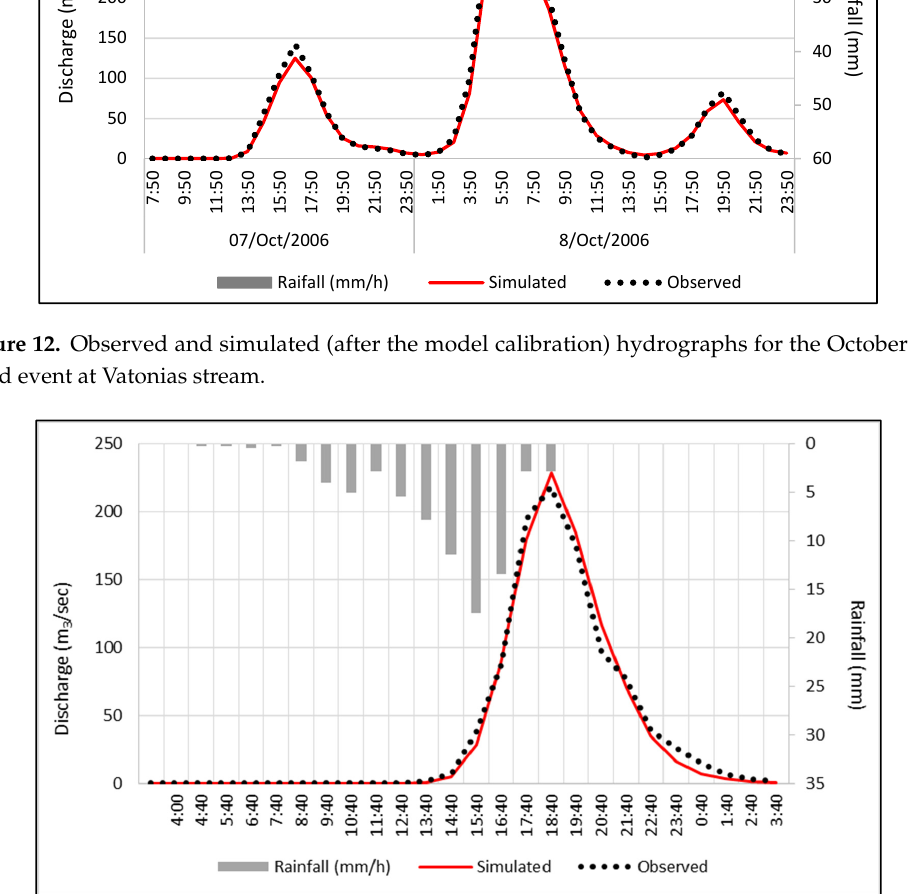
Figure 14. Simulated hydrograph of the June 2018 flood event at Kryoneri stream (east Stavros).